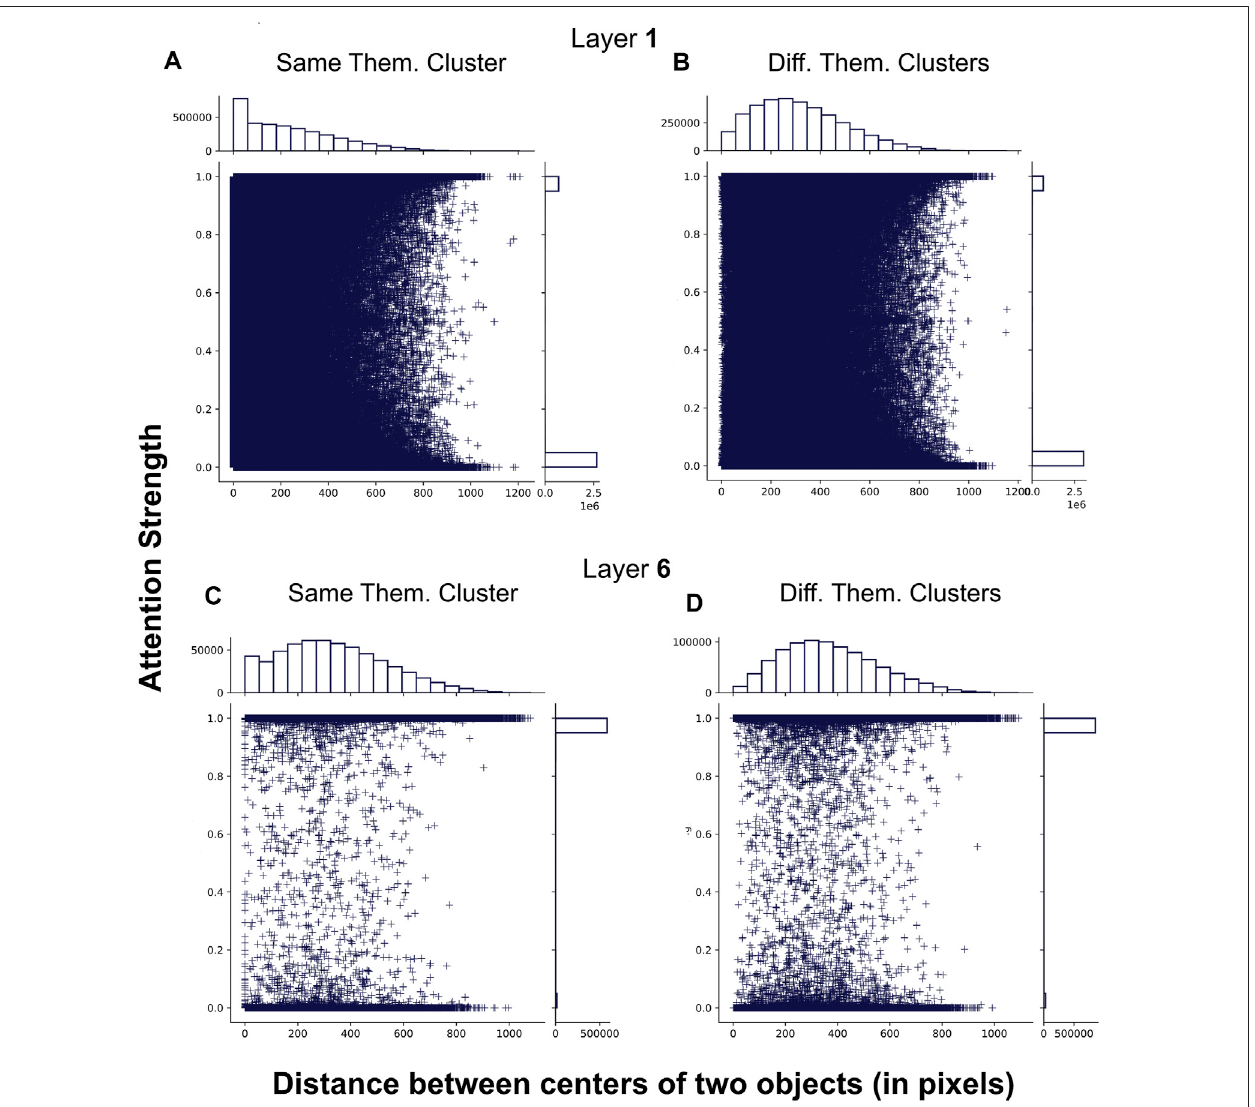
FIGURE 6 | Four visualisations portraying the distribution of attention links (depicted as +marks) in terms of their strength (the vertical axis) and distance between centres of two connected objects (the horizontal axis). We split attention links into two groups: those between the objects that are either in the same or a different thematiccluster. (A) and (B) demonstratethepatternsobservedinthe fi rstlayer,while (C) and (D) demonstratepatternsinthelastlayeroftheimageencoder.Amarginal histogram accompanies each visualisation for both the vertical (top) and the horizontal (right) axes. The histograms show a distribution of +marks for each dimension(eitherhorizontalorvertical)inthescatterplotde fi nedbyamaximumof20bins.Thescalesforthebarsizes(e.g.,frequenciesofmarksineachbar)areshown on the left side of the horizontal histogram and below the vertical